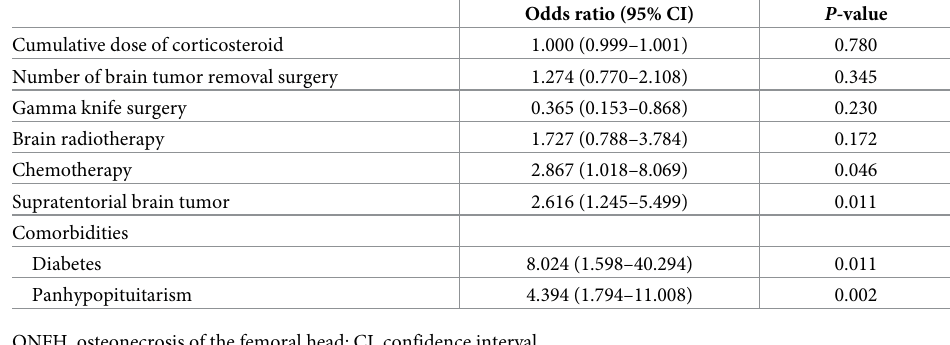
Table 4. Univariate logistic regression analysis of variables associated with the development of ONFH in brain tumor patients. Odds ratio (95% CI) P -value Cumulative dose of corticosteroid 1.000 (0.999–1.001)